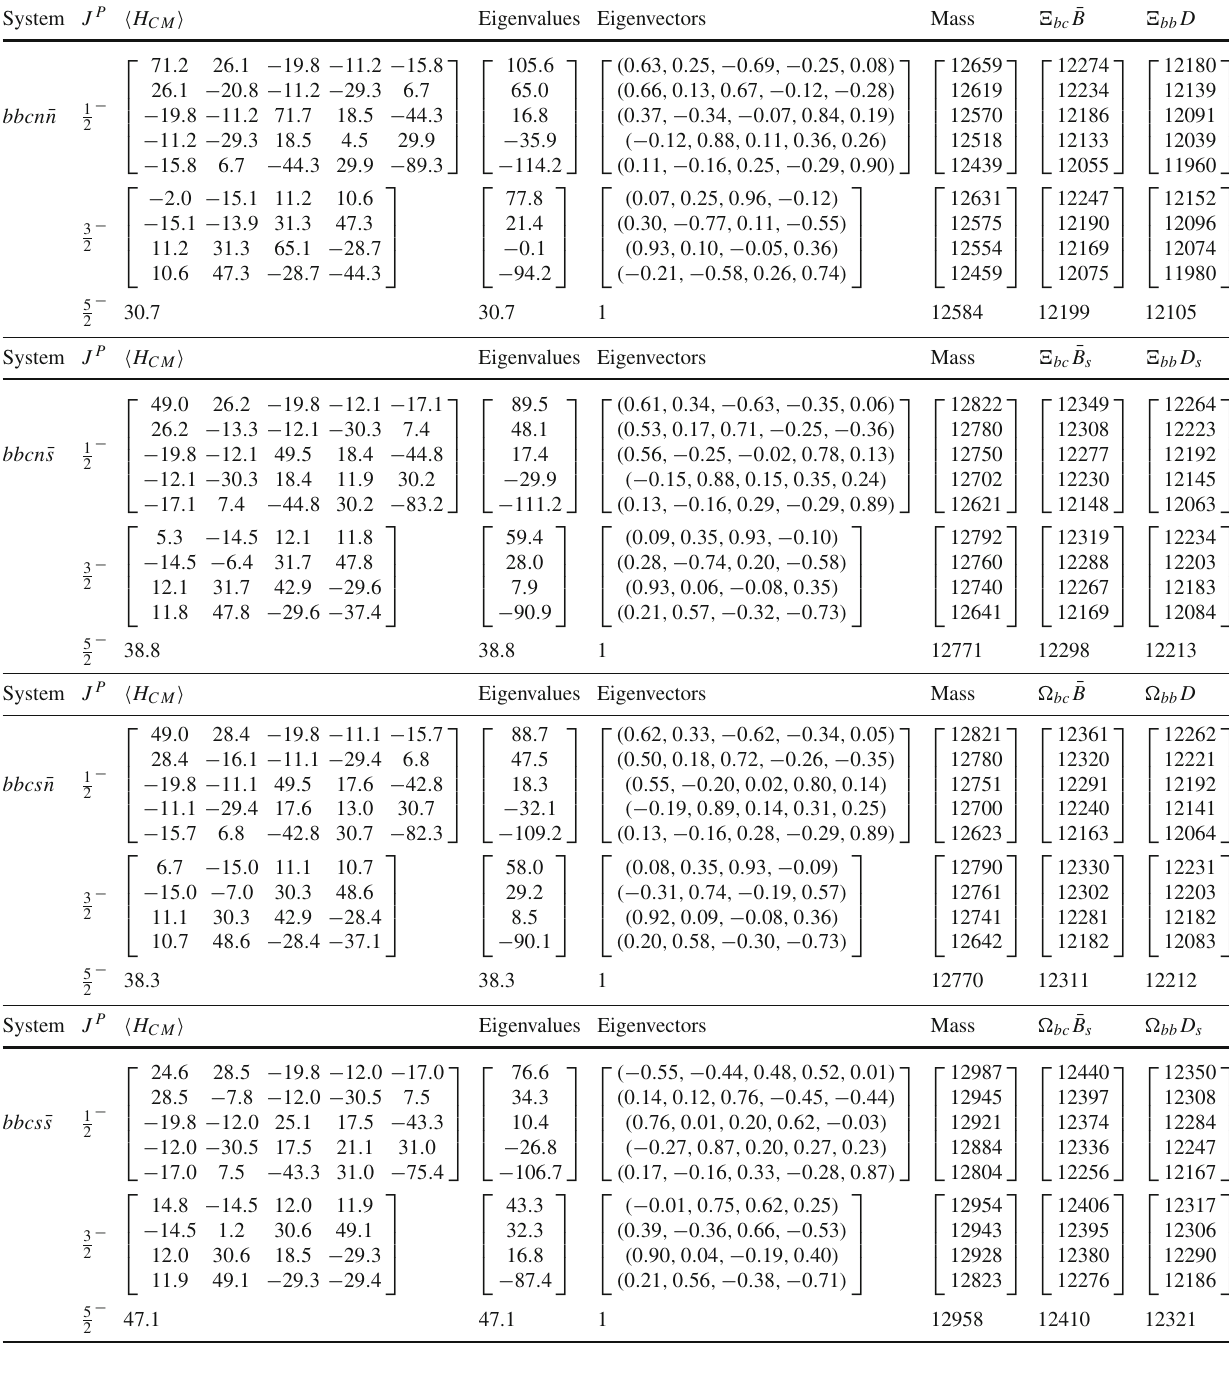
Table 8 Numerical results for the bbcq ¯ q systems in units of MeV. The masses in the sixth column are estimated with Eq. (18) and those in the last two columns with the ( bcq ) - ( b ¯ q ) type and ( bbq ) - ( c ¯ q ) type thresholds, respectively System J P (cid:8) H CM (cid:4) Eigenvalues Eigenvectors